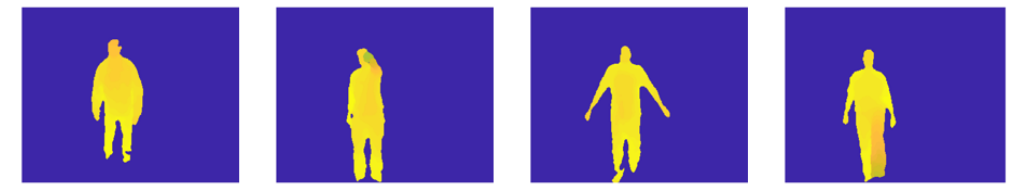
Figure 8. Samples of the Microsoft Research (MSR) 3D action dataset [51].